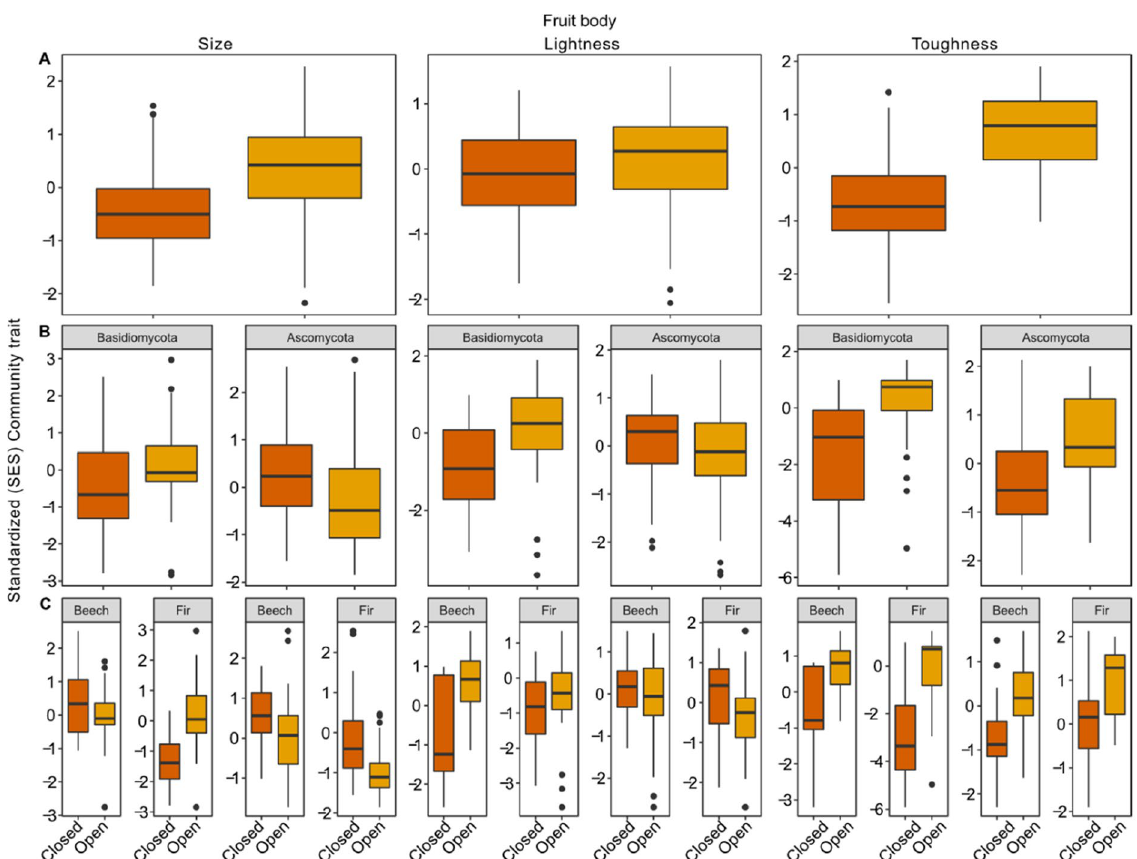
Figure 4. Response of the standardized effect size of the community fruit body traits with canopy openness. Dark orange refers to closed canopies, light orange to open canopies. Standardized effect sizes (SES) were computed based on the independent swap null model. ( A ) Effects of canopy openness on the overall community trait. ( B ) Effects of canopy openness on the community trait separated for Basidio- and Ascomycota. ( C ) Effects of canopy openness on the community trait separated for lineages and tree species. For a statistics table based on a multivariate linear mixed-effects model, see Table 1. R programming environment version 4.1.2 40 and R add-on package ggplot2 41